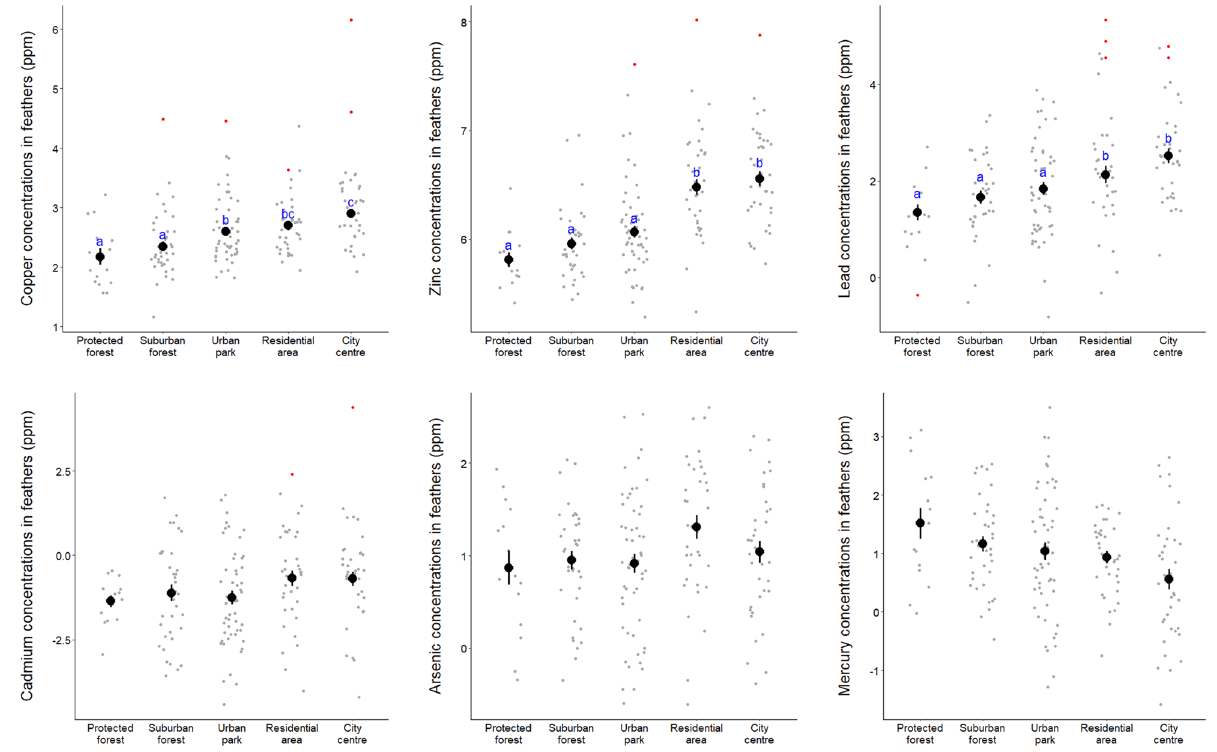
Figure 4. Mean ± se MTE concentrations (Cu, Zn, Pb, Cd, As or Hg after log-transformation; in ppm) per habitat category (protected forest, suburban forest, urban park, residential area or city centre). Significant differences of MTE concentrations between habitat categories are indicated by different